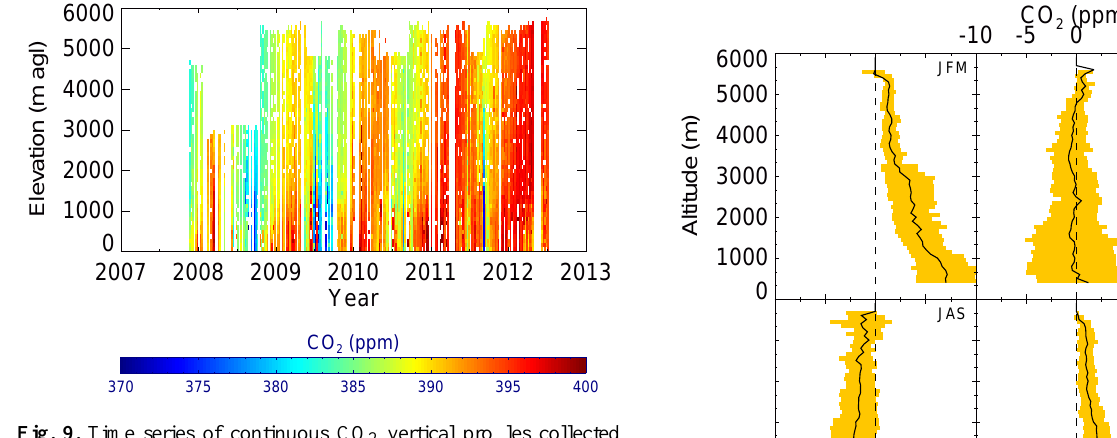
Fig. 9. Time series of continuous CO 2 vertical profiles collected from November 2007 through 31 July 2012 from RM0.